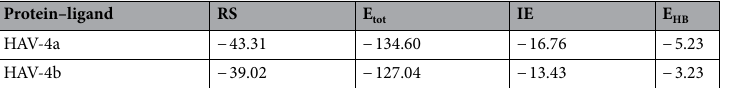
Table 1. Molecular docking score of Hepatitis A virus with ligand (4a and 4b) in the favorable cavity. RS Re-rank score is linear combination of internal (Steric, Van der Waals, Hydrogen bonding, and Electrostatic) and external (Torsion strain, Torsion strain sp 2 -sp 2 , Hydrogen bonding, Van der Waals, and Electrostatic) energies. E tot total interaction energy between protein and pose, IE internal energy of pose, E HB hydrogen bonding energy.